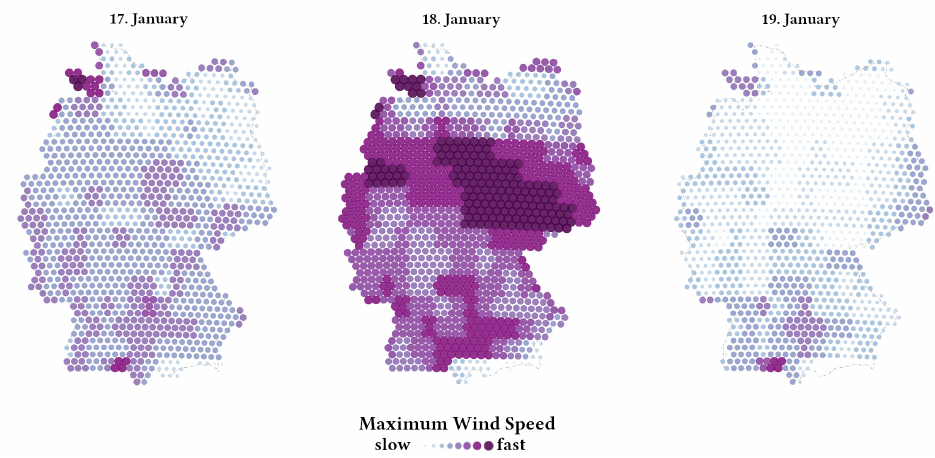
Figure 9. Three-hourly wind speed maxima interpolated according to 20 km-wide hexagons based on data from the Global Forecast System (GFS) for the period between 17 and19 January 2018. Areas with small light blue dots represent slow daily maximum wind speeds for the days, whereas large dark purple dots show areas with high daily maximum wind speeds. Note that the recorded peak values measured with weather stations by the German Meteorological Service are significantly higher than the GFS data